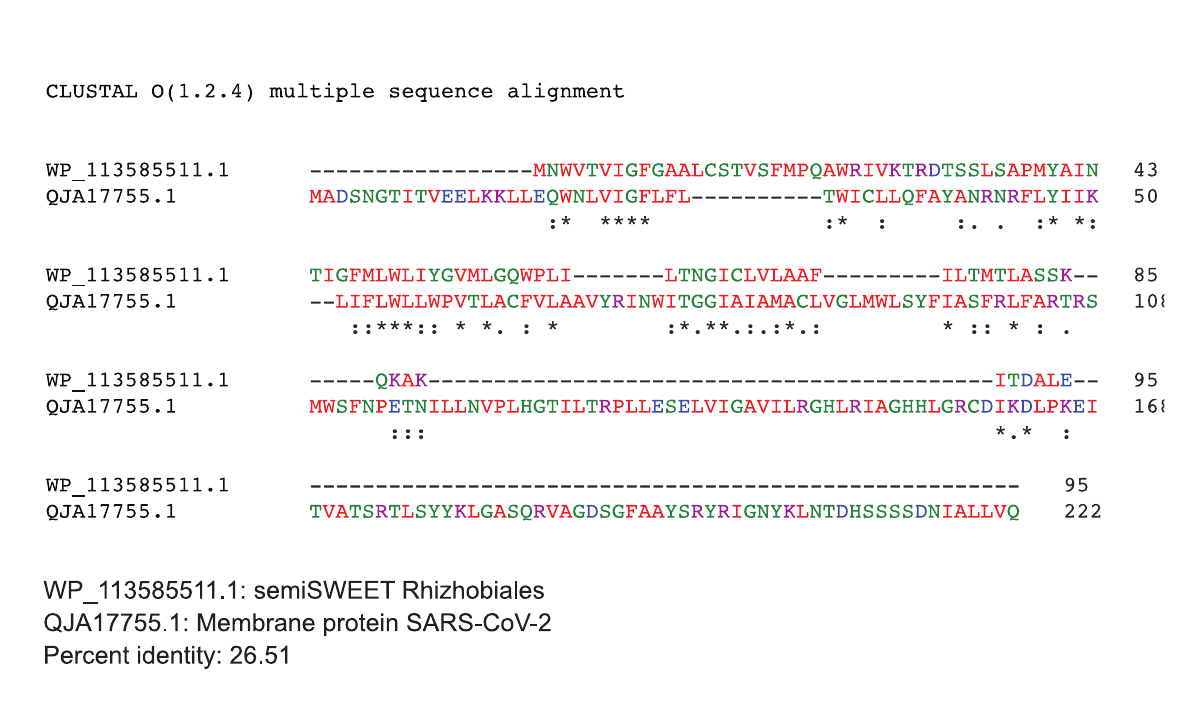
Figure 5. Protein sequences were aligned using ClustalW. (A) Comparison of protein sequence of the M protein of SARS-COV-2 with SemiSWEET sugar transporter of Rhizobiales. (B) Comparison of protein sequence of the M protein of SARS-COV-2 with SemiSWEET sugar transporter of Streptococcus